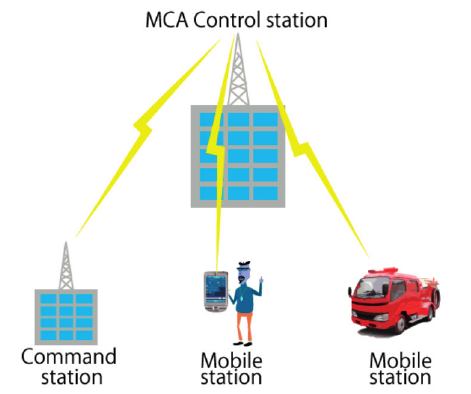
Figure 3. One example of a system based on the Multi-Channel Access